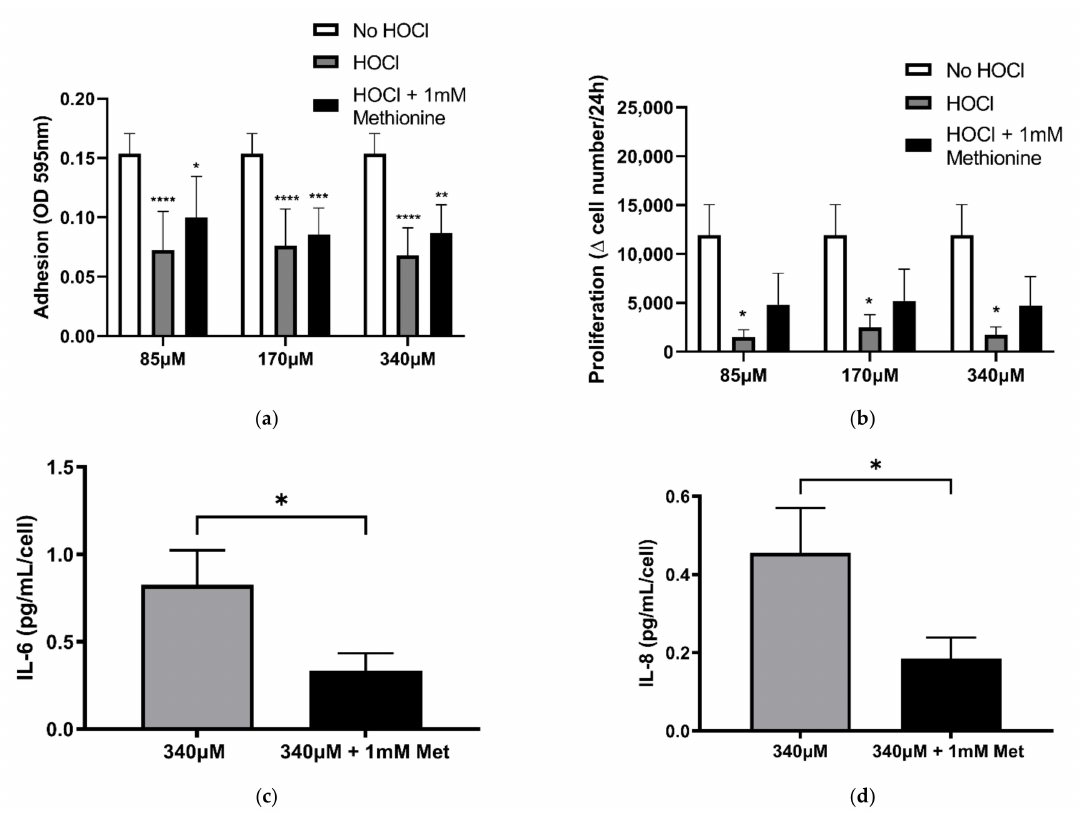
Figure 7. Comparison of the effects of chloramine quenched against HOCl-induced oxidation of BEAS-2B-derived ECM on fibroblast function. BEAS-2B derived ECM was oxidised with (or without) HOCl concentrations of 85 µ M, 170 µ M, and 340 µ M for 30 min, and was then incubated for 10 min with or without methionine (1 mM) to quench chloramine. PHLF were seeded onto these matrices for 2 h ( a ) and 96 h ( b – d ). ( a ) Attachment was assessed by Coomassie brilliant blue staining; ( b ) manual cell counts. IL-6 ( c ) and IL-8 ( d ) release at 24 h was measured by ELISA. n = 5 for all. **** p < 0.0001, *** p < 0.001, ** p < 0.01, * p < 0.05, significance was compared against No HOCl; two-way ANOVA with Tukey’s multiple comparison test was performed. ( c , d ) n = 5. * p < 0.05, significance was compared against 340 µ M HOCl; 2-tailed paired Student t test was